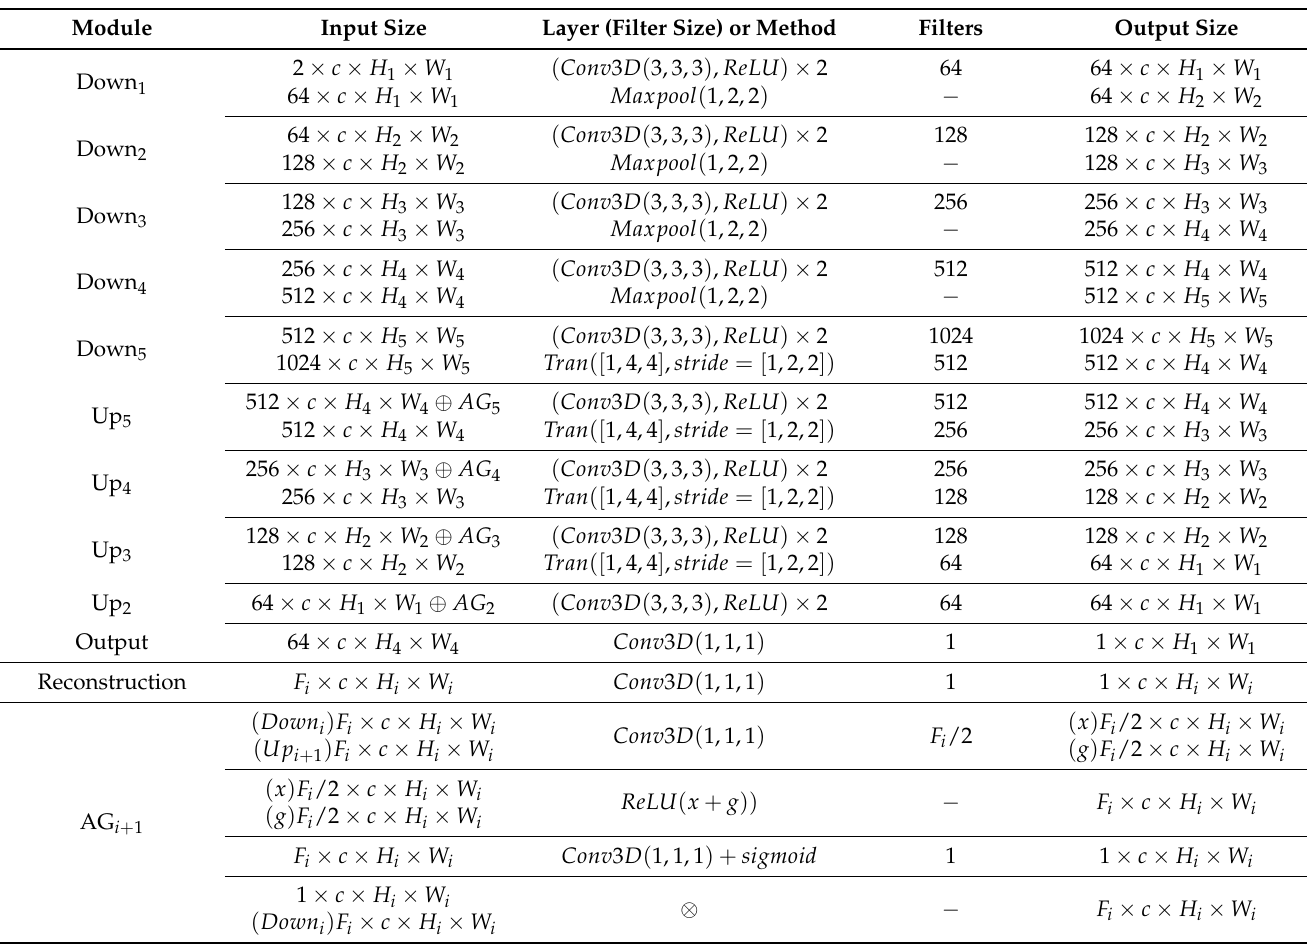
Table 1. The design of the